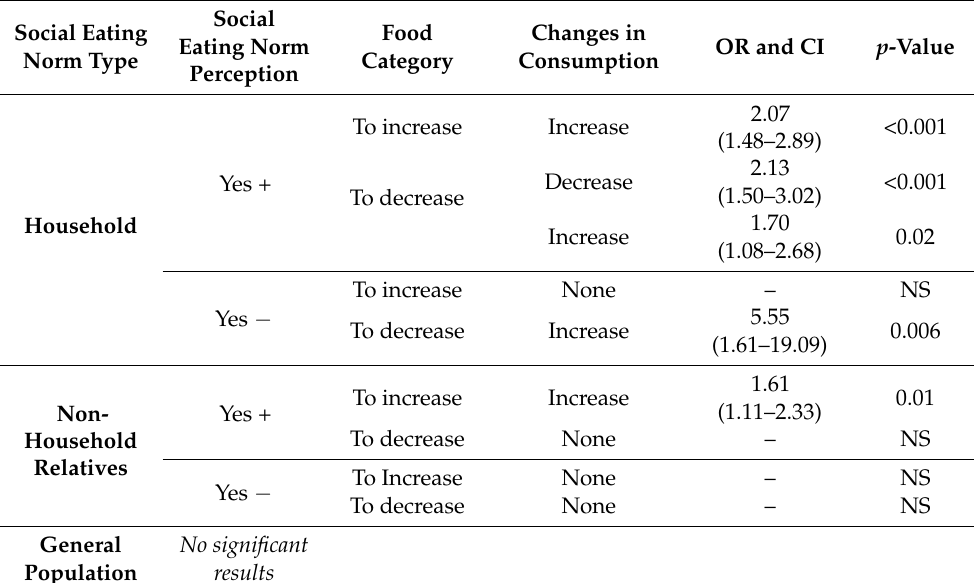
Table 4. Results of multinomial logistic regressions evaluating the influence of perceived lockdown social eating norms on changes of consumption for the two food categories.